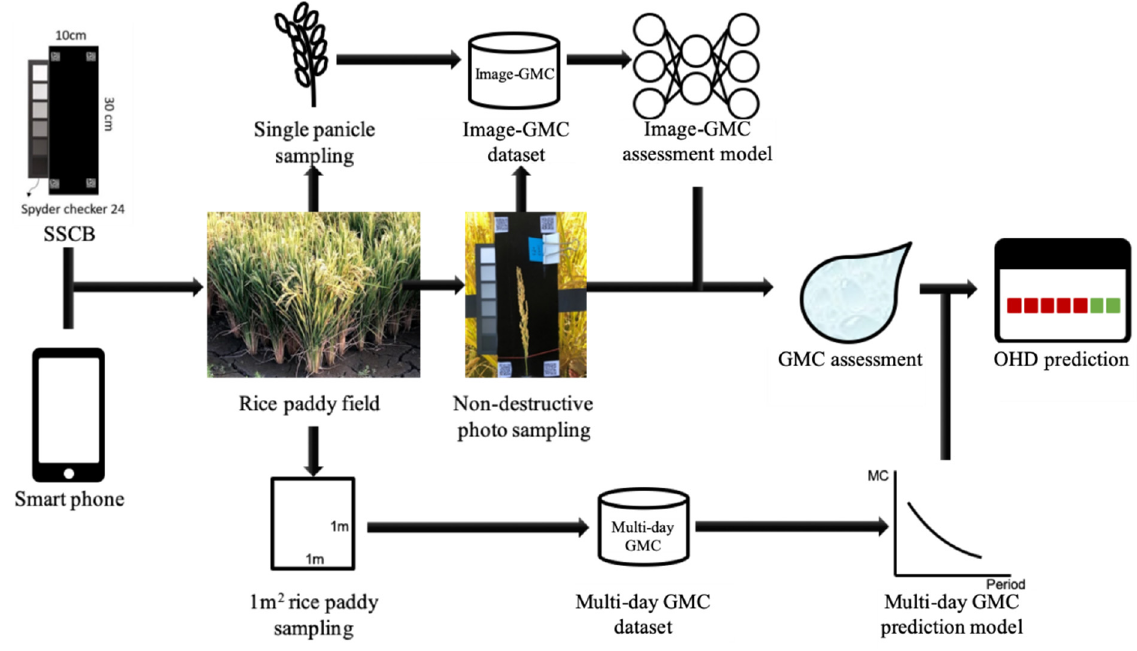
Figure 1. Research process and scenarios.